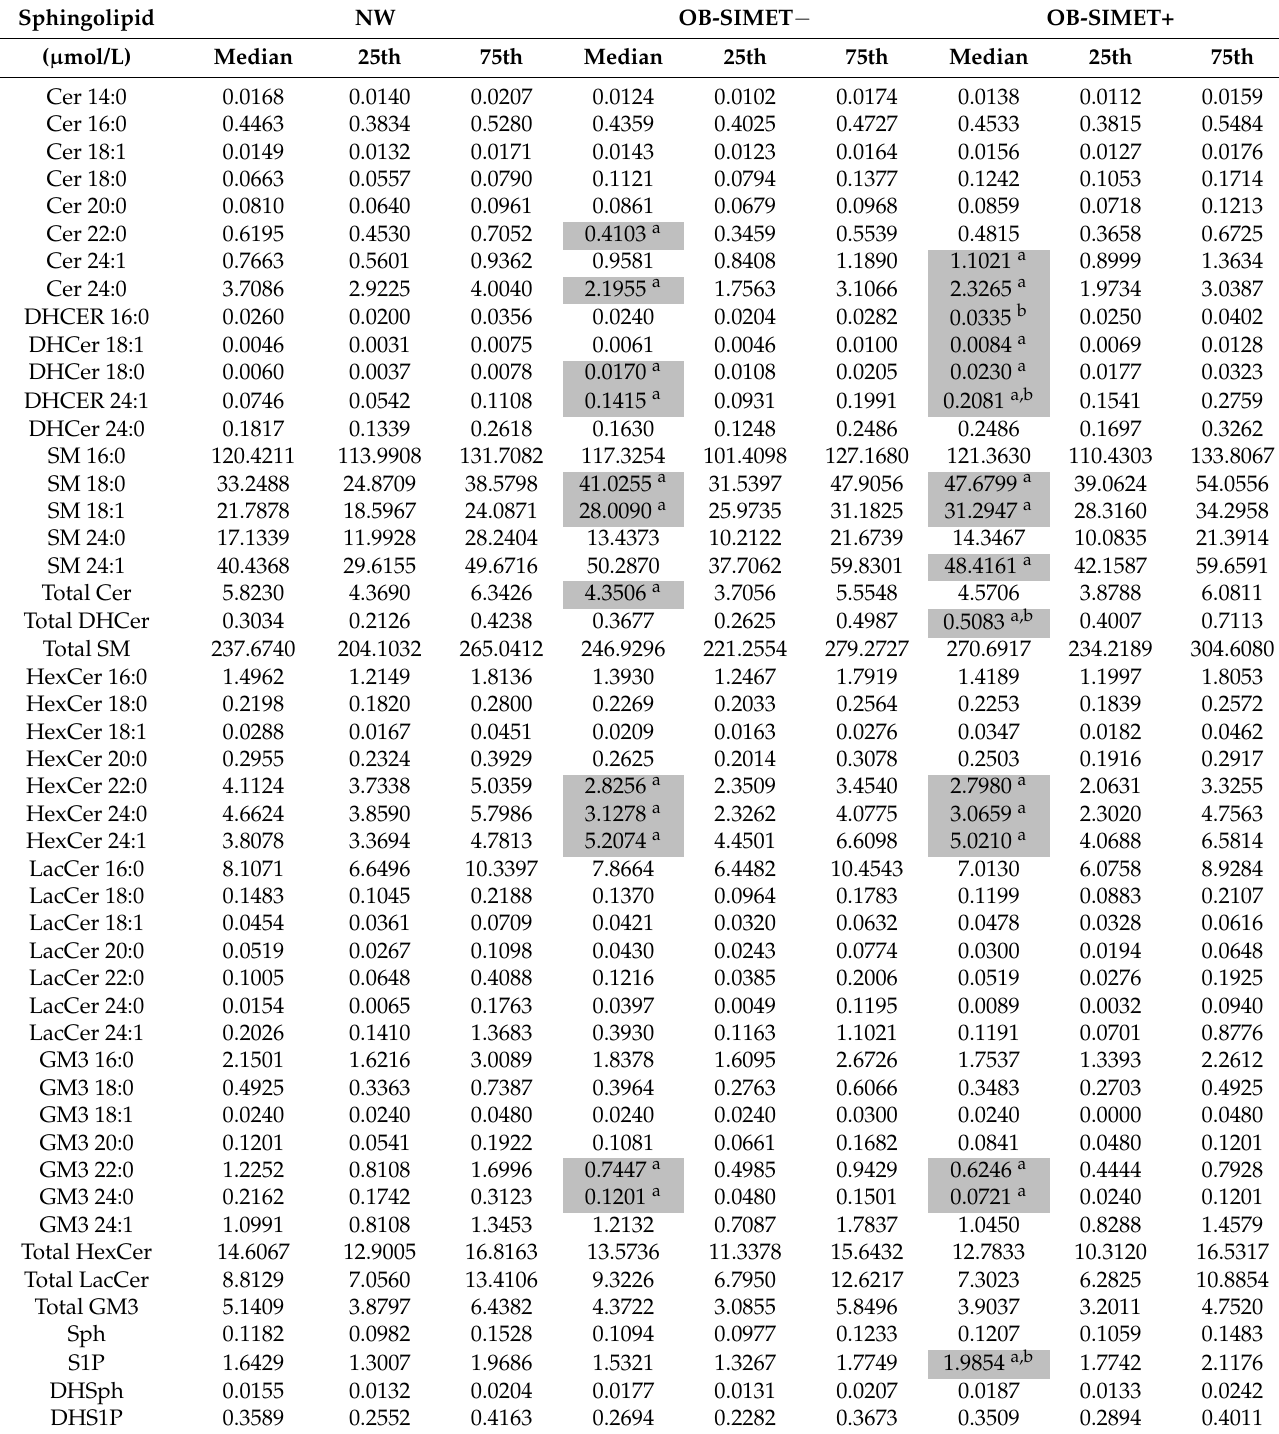
Table 2. Plasma sphingolipidomics in the study population, subdivided into three groups: normal- weight (NW) and obese subjects without (OB-SIMET − ) or with (OB-SIMET+) metabolic